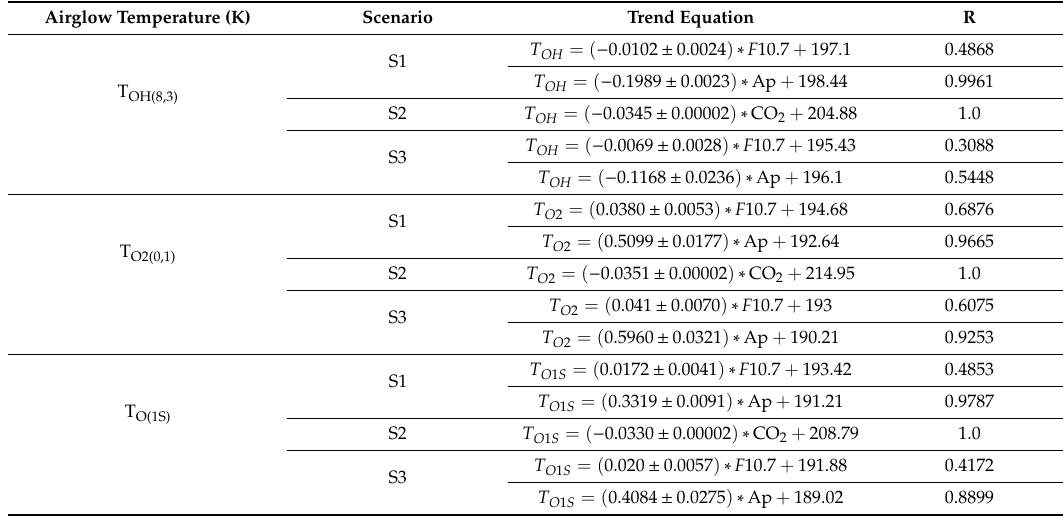
Figure 5. Linear regression of the simulated airglow temperature as a function of F10.7 index for Figure 5. Same as Figure 4, but for F10.7. The simulated airglow temperatures all display a moderate S1 scenario. ( a ) For OH, ( b ) for O 2 and ( c ) for O1S temperature. The simulated airglow temperatures correlation with F10.7. all display a moderate correlation with F10.7. Table 1. Trends as a function of F10.7, Ap index, or CO 2 gas concentration in OH(8,3) airglow, O 2 (0,1) atmospheric band and O( 1 S) greenline temperatures for the three